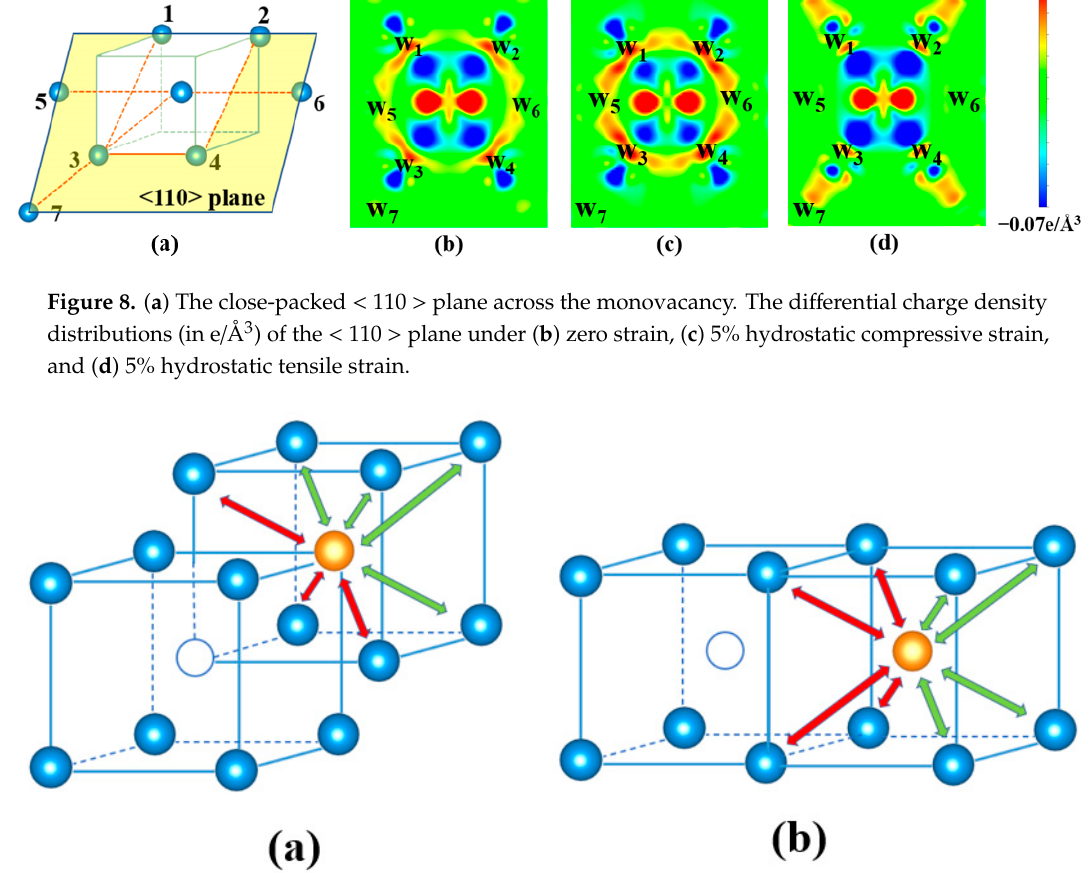
Figure 10. Effects of hydrostatic and biaxial strain on the binding energy of divacancy in W.